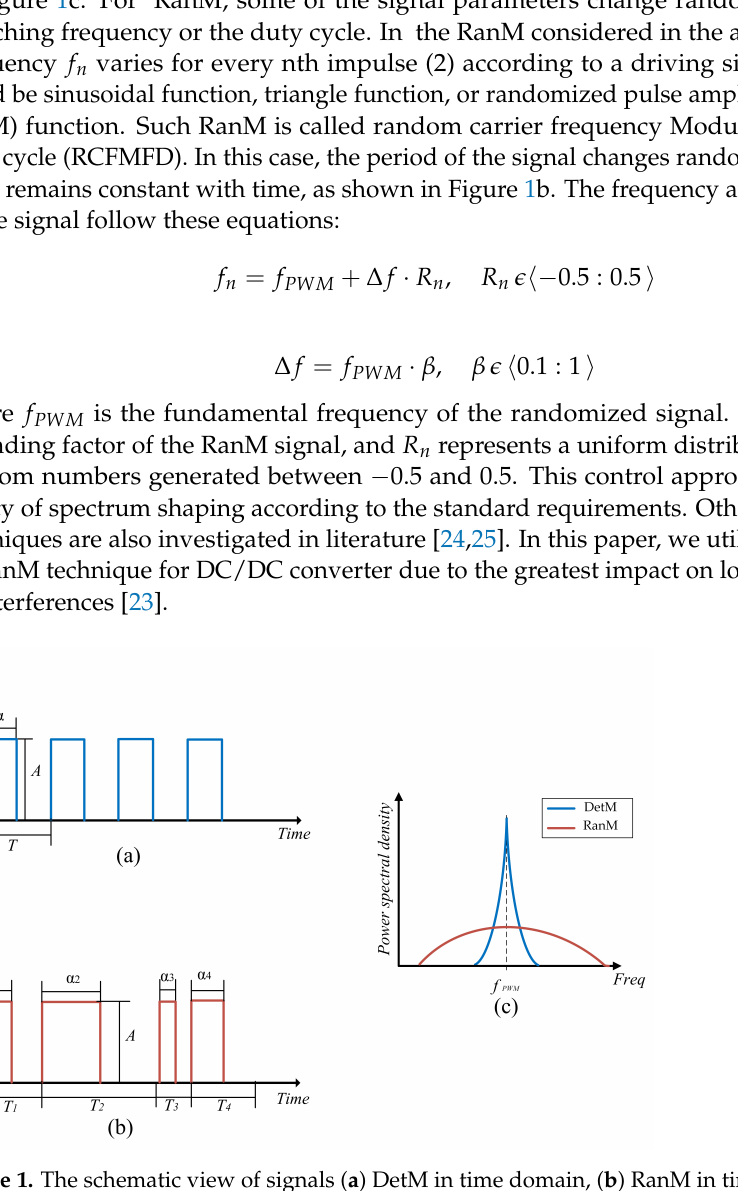
Figure 1. The schematic view of signals ( a ) DetM in time domain, ( b ) RanM in time domain, and ( c ) both modulations in frequency